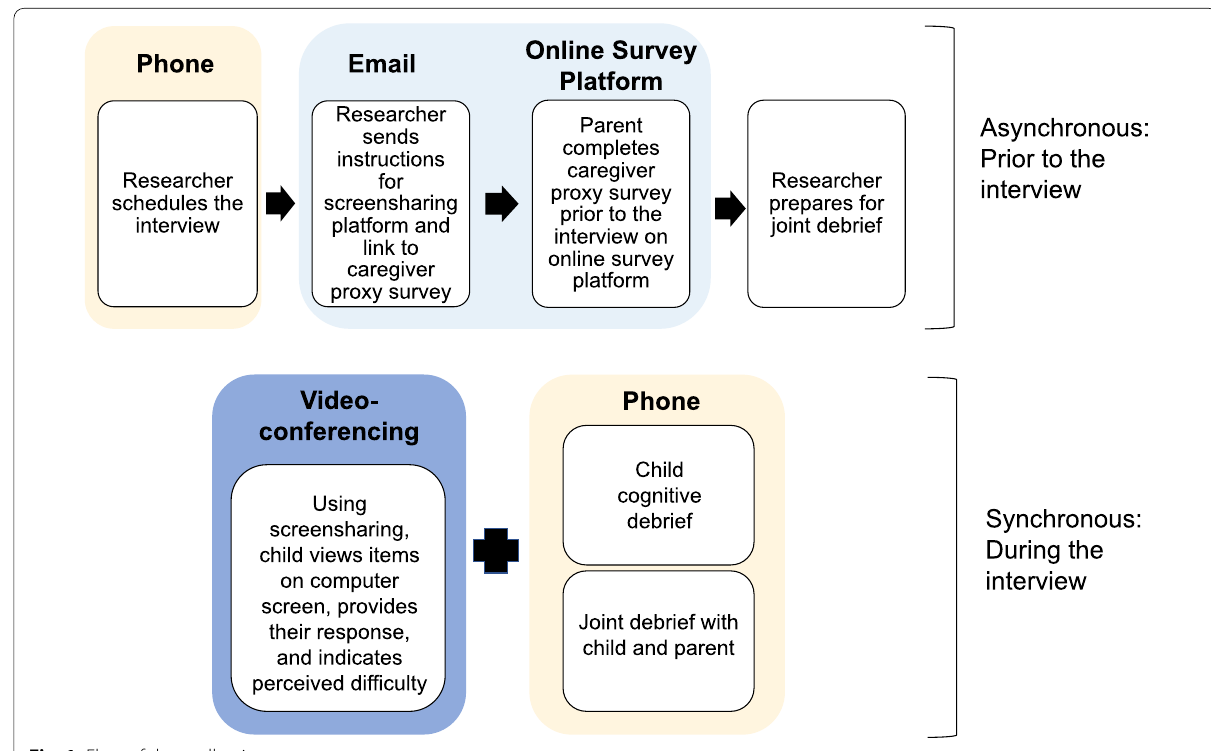
Fig. 1 Flow of data